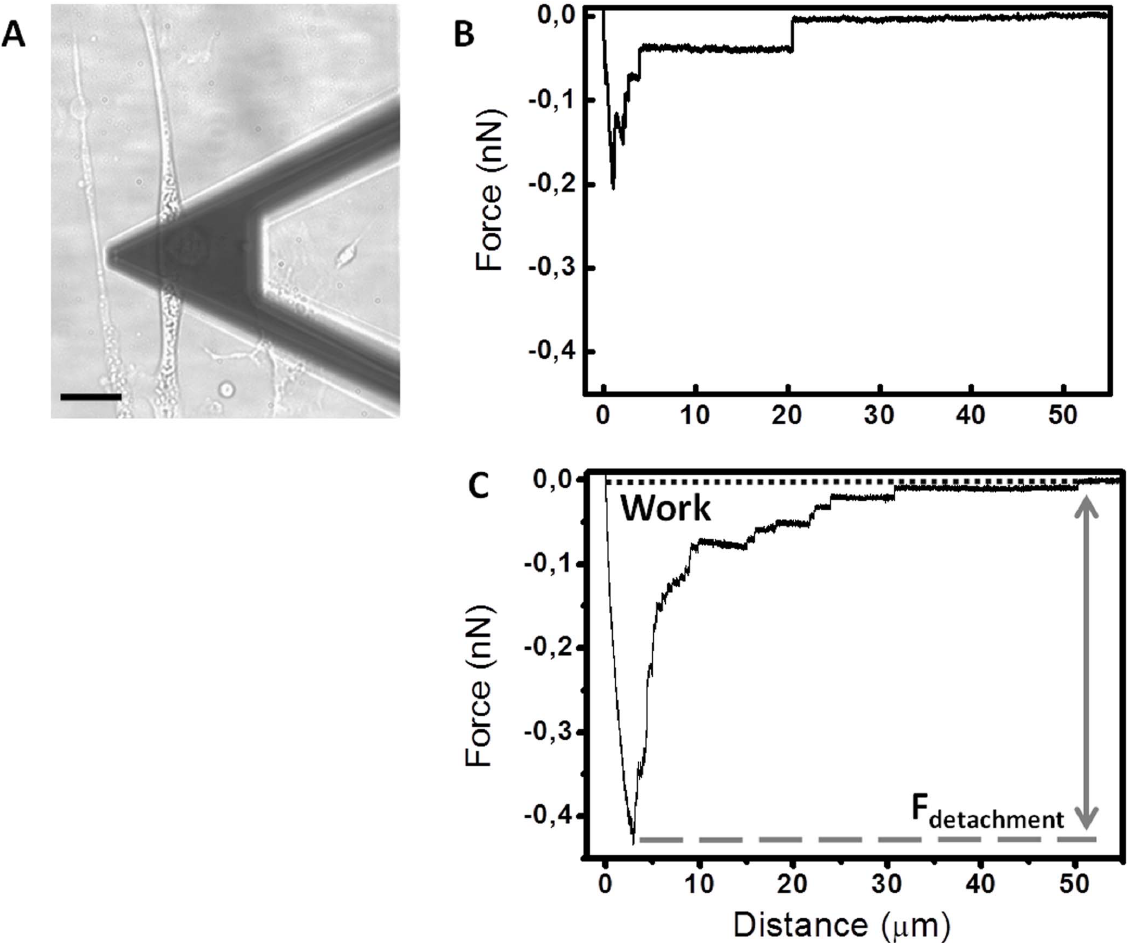
Figure 3. Cell-cell adhesion measurements. ( A ) Differential interference contrast (DIC) optical image of a GSC immobilized on a tipless cantilever brought into contact with a GASC cultured on glass coverslip coated with fibronectin (scale bar 20 m m); representative F-D retraction traces acquired for GSC-GASC ( B ) and Gsc-Gasc ( C ) for 10 sec contact time; features of the curves that enables to quantify adhesion properties are highlited: the maximum force exerted to detach the cell (F detachment ); the area, included within the retraction curve and the dot line, represents the work done by the cantilever to completely detach the cell from the substrate (work of detachment).